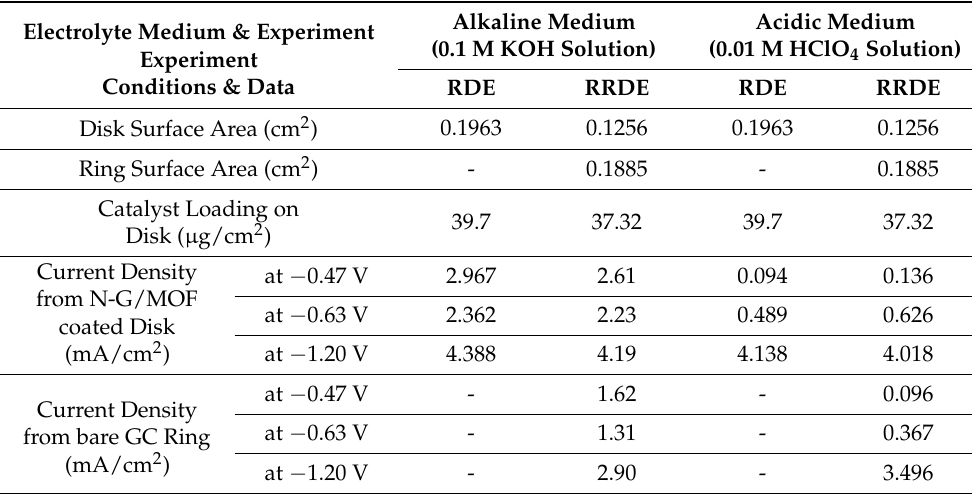
Table 1. Data Comparison of RDE and RRDE experiments of N-G/MOF in both acidic and alkaline mediums. All the other experiments conditions are